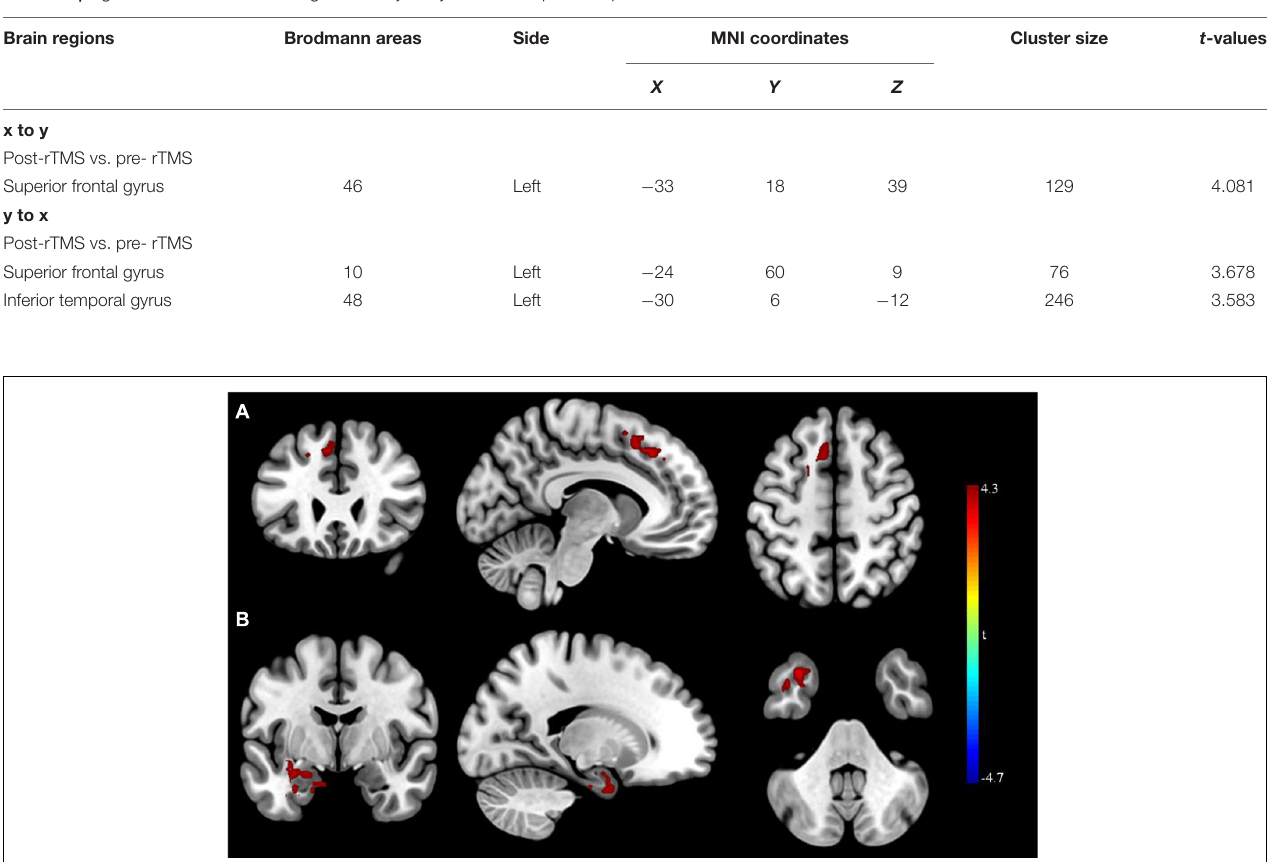
TABLE 8 | Significant differences in Granger causality analysis between pre- and post- rTMS.